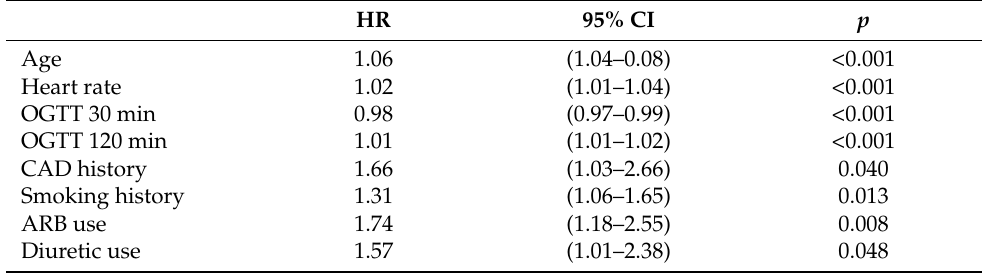
Table 2. Features selected by the LASSO-derived Cox proportional hazards model.